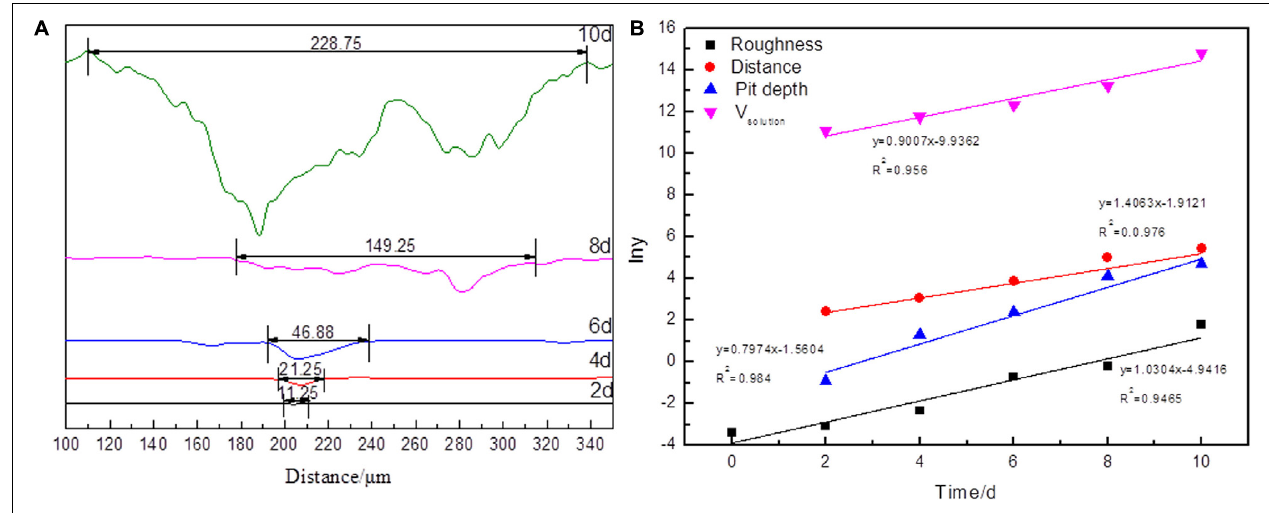
FIGURE 6 | The profile of the pits (A) in arsenopyrite slice and plot of Kt versus time for arsenopyrite dissolution (x = time) (B) after bioleaching for 2, 4, 6, 8, and 10 days with mixed culture at pH 1.5, 45 ◦ C with an initial cell density of 1.8 × 10 8 cells/mL. The arsenopyrite slices were washed with 1 M HCl measurement. The curves were measured by a laser microscope and analyzed with a OLYMPUS Stream software for 3D